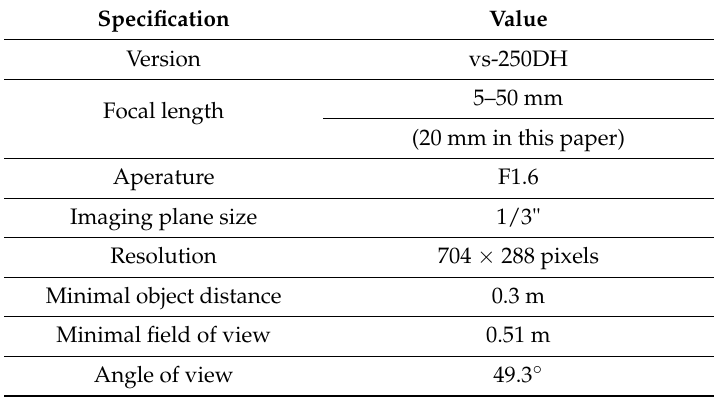
Table 2. Specifications of the VS250DH vision sensor.